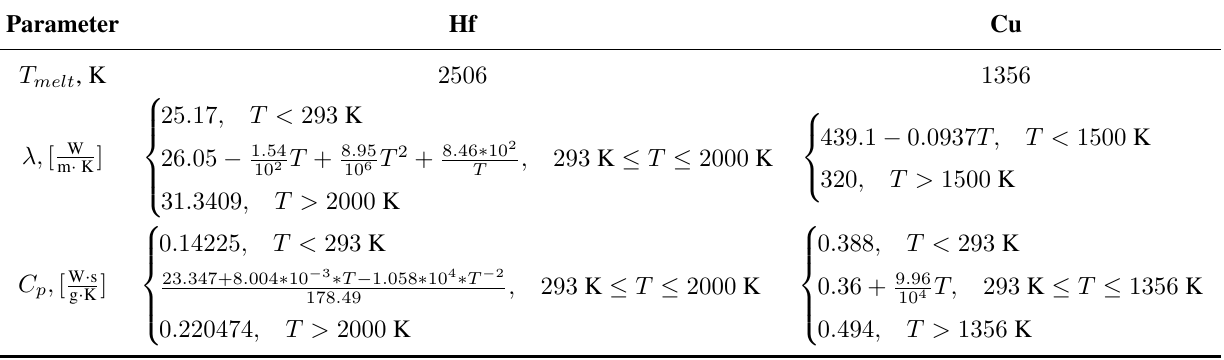
Table 1. Material characteristics used in